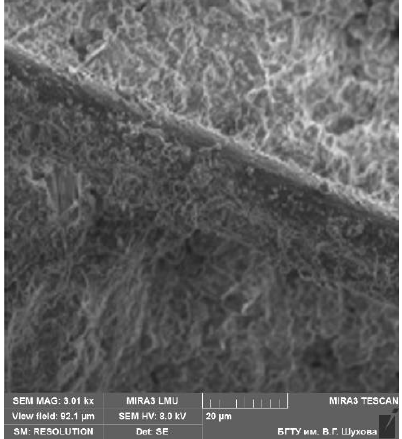
Figure 11. Fiber mortar interfacial transition zone (specimen 4).